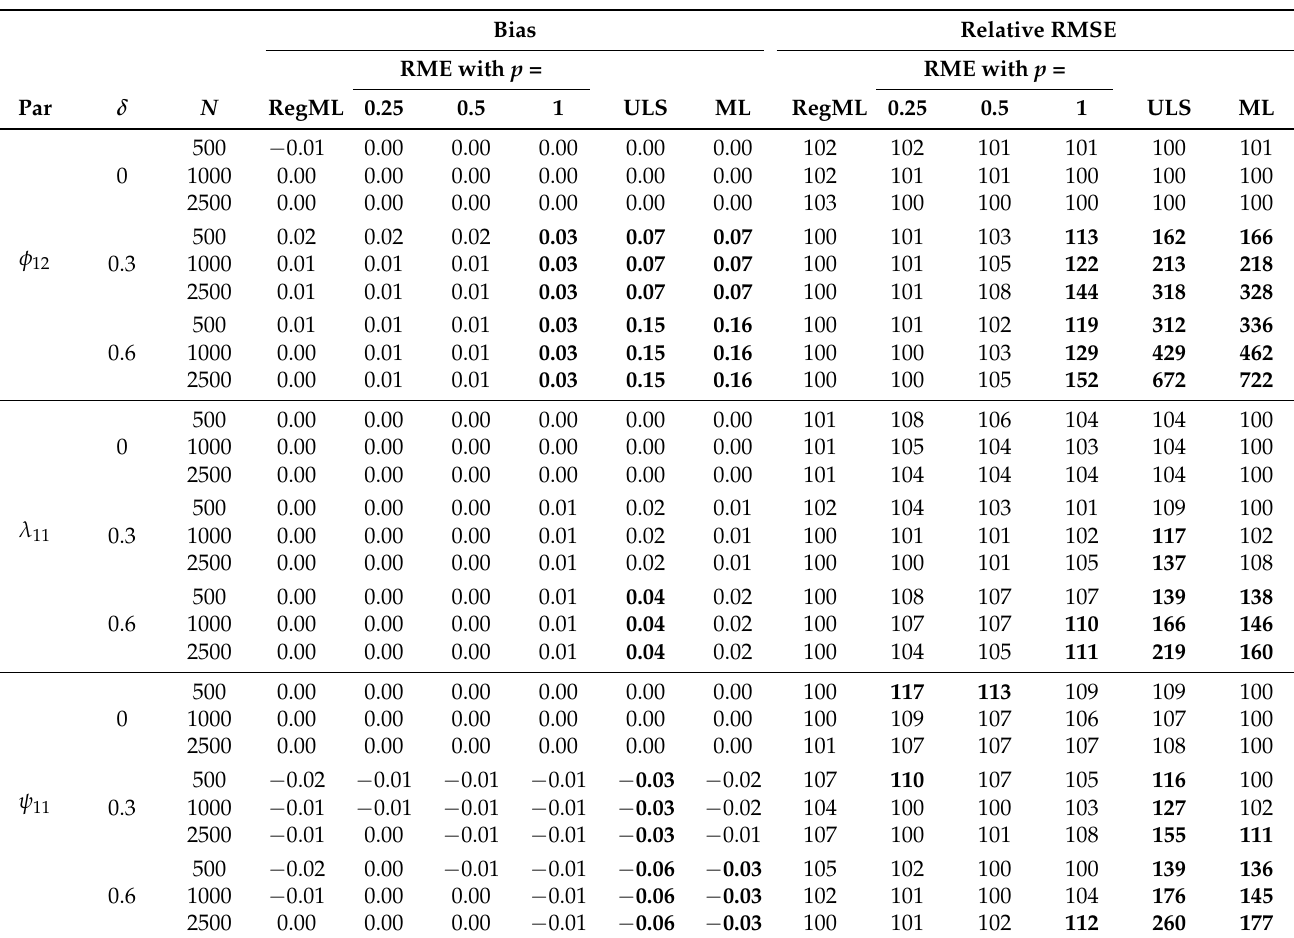
Table 1. Simulation Study 1: Bias and relative root mean square error (RMSE) of model parameter estimates as a function of sample size N and size of residual error correlations δ